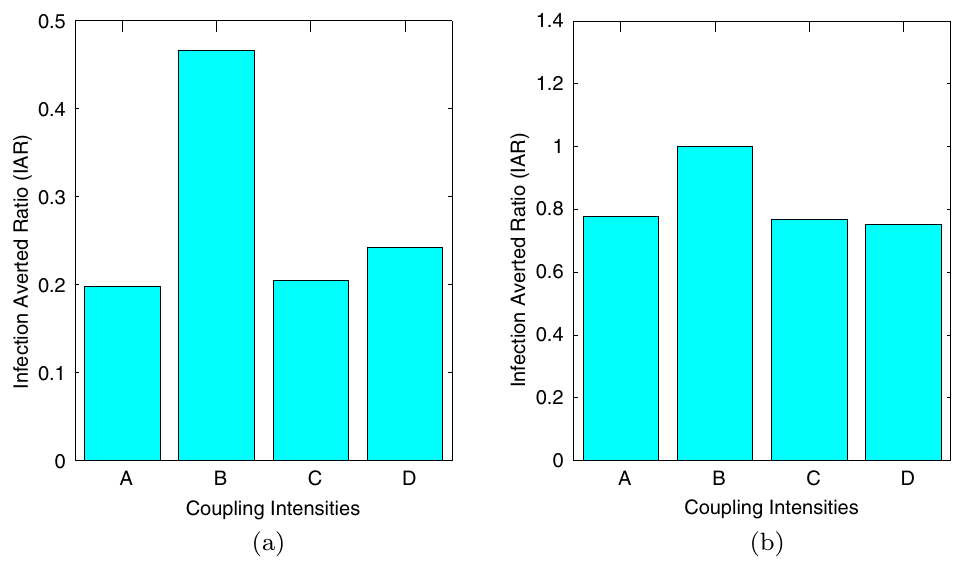
Figure 12. Graphs of ( a ) showing the infection averted ratio (IAR) for case 1 and ( b ) showing the infection averted ratio (IAR) for case 2.